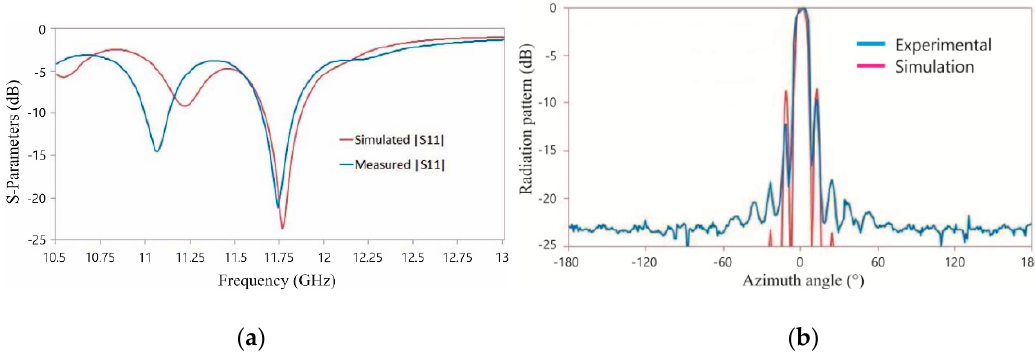
Figure 24. Antenna prototype built with the empty SIW [82].